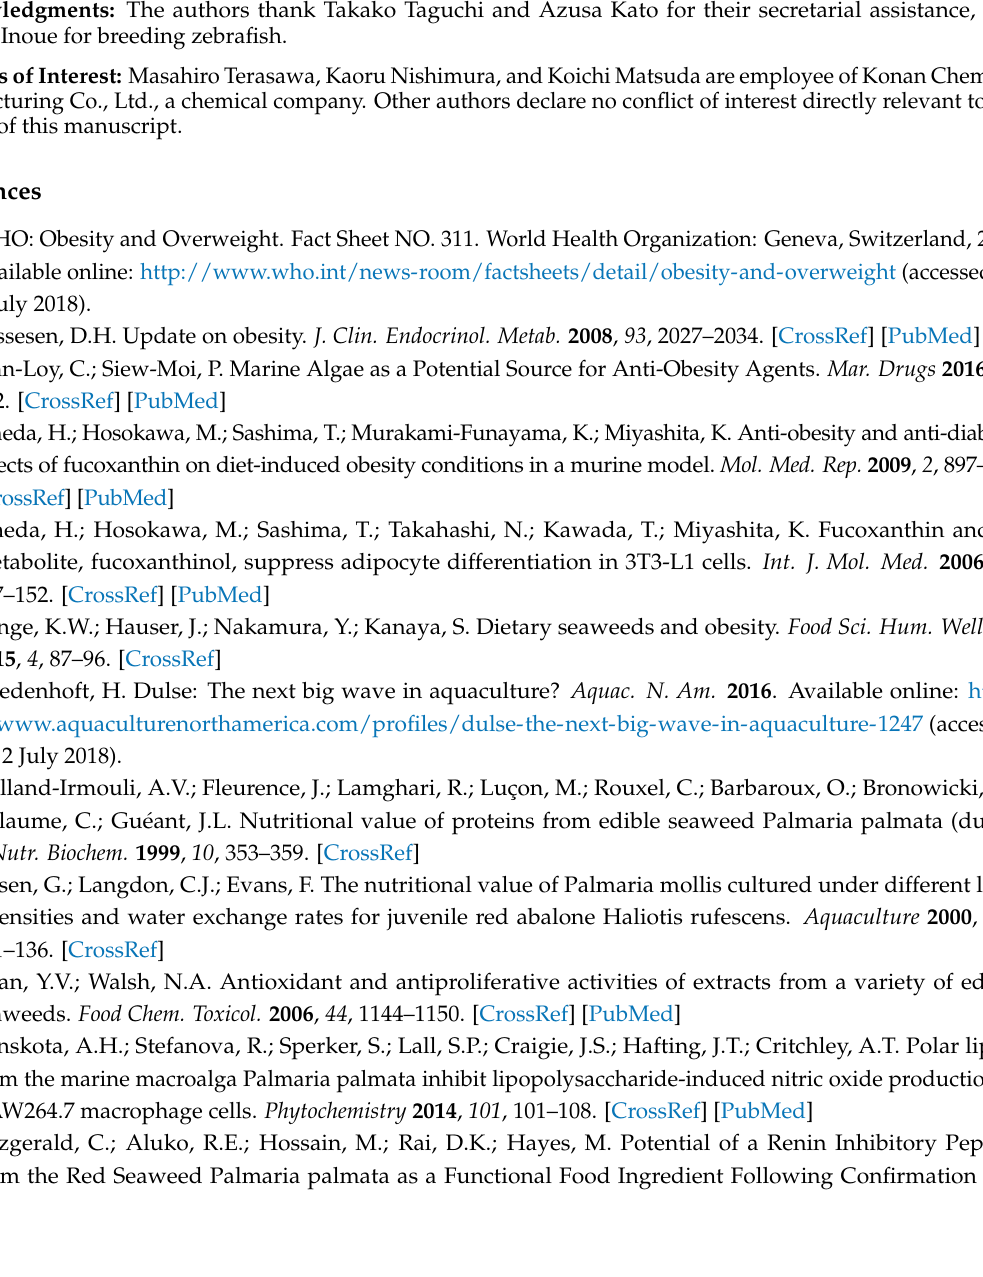
Table S1. Food compositions of control diet (ND) and high fat diet (HFD) in mice; Table S2. Primer sequences for